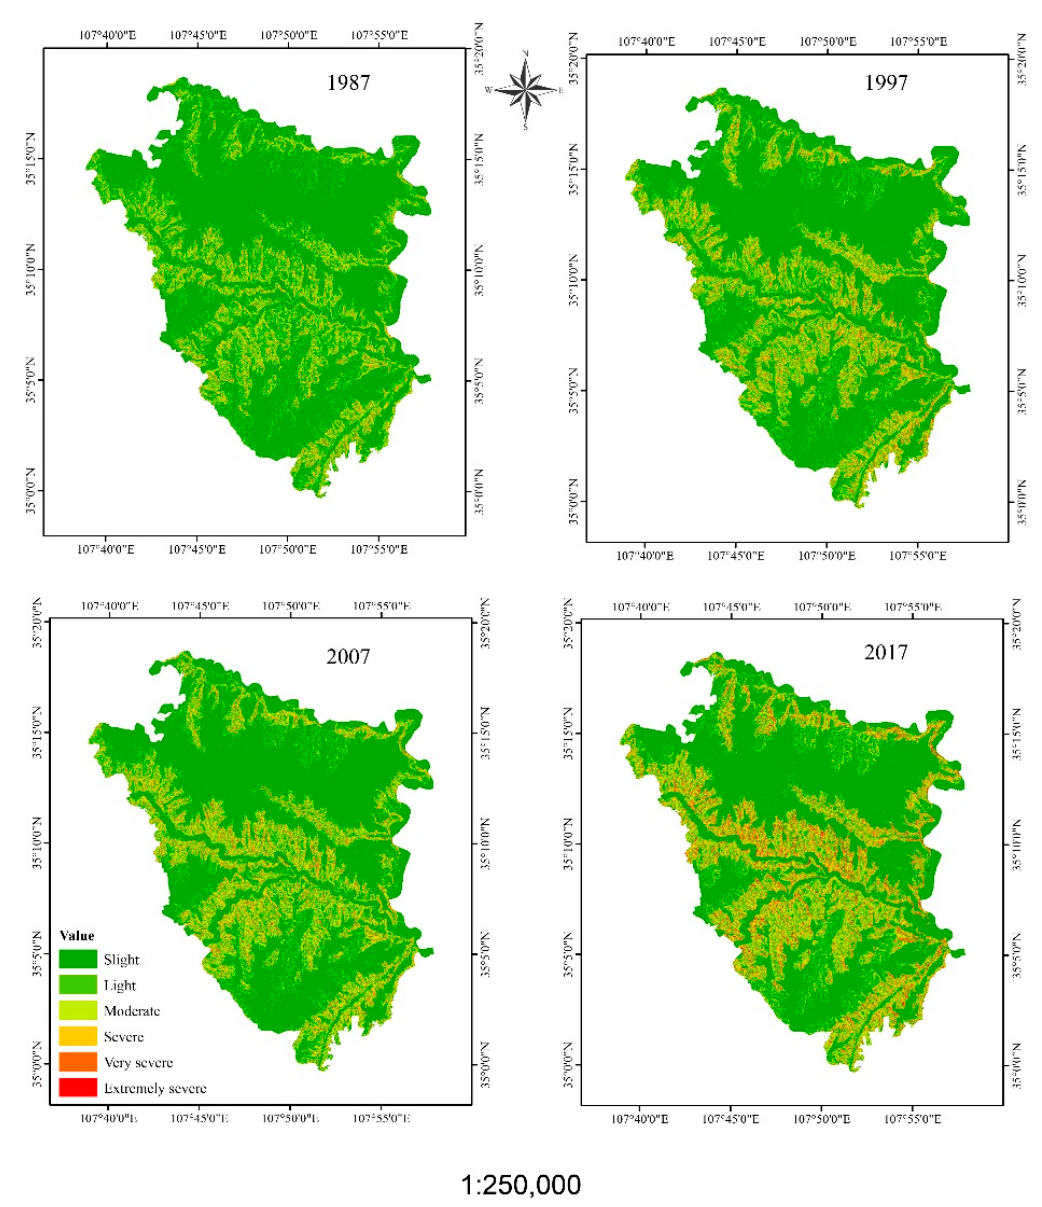
Figure 5. This figure shows the annual average soil erosion in six classes (slight, light, moderate, severe, very severe, and extremely severe) for 1987, 1997, 2007, and 2017. The soil erosion classes are based on the RUSLE model applied and the standards for the classification and gradation of soil erosion SL190-2007 issued by the Ministry of Water Resources of China.